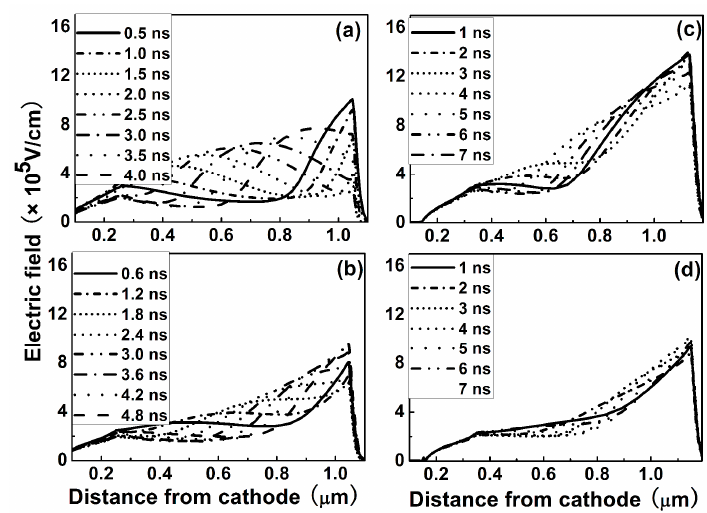
Figure 5. Electric field profiles derived inside one oscillation circle at the same time steps, when the diode is applied at different voltage: ( a ) V dc = 50 V and ( b ) V dc = 75 V under EB model; and ( c ) V dc = 50 V and ( d ) V dc = 55 V under NEB model.